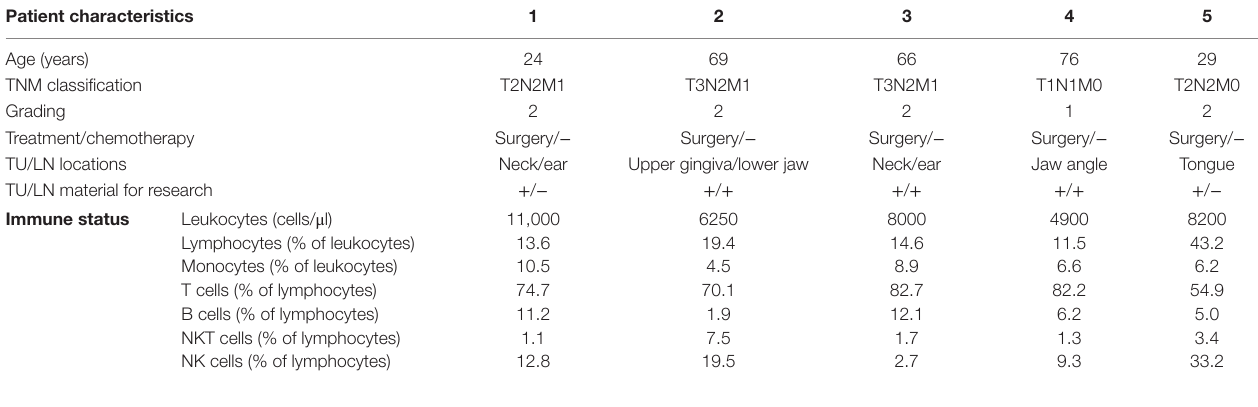
TaBle 1 | The clinical parameters and immune status of hnscc ( n = 5) patients summarized after tumor (TU) and lymph node (ln) surgery but before any acute clinical therapeutic